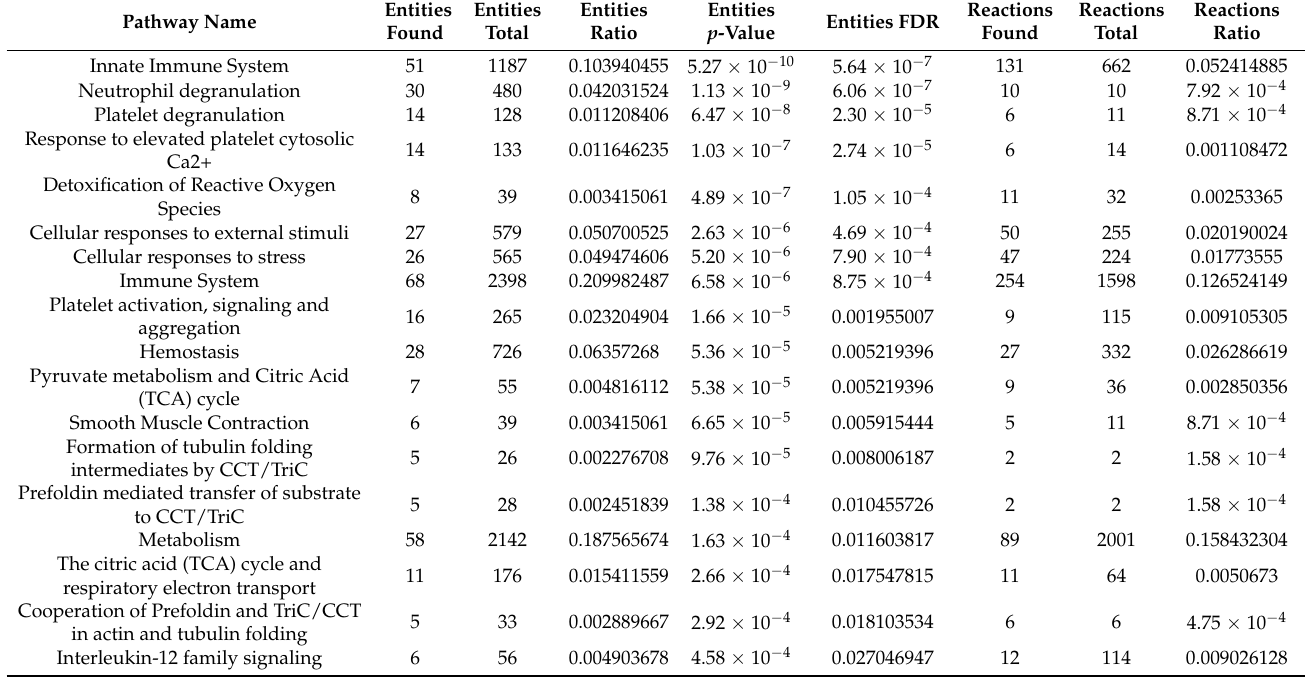
Figure 2. Pathway overrepresentation analysis of the protein elements characterizing the ND GBM tumor zone. The Reactome hierarchical pathway overrepresentation analysis in reference to Homo sapiens database found 168 identifiers over the 193 of the input list of the tumor zone and outlined the 25 most relevant pathways listed in Table 1, following a binomial test to calculate the result probability and by correcting the p -values for the multiple testing. Table 1. Result of the 25 most relevant Reactome pathways overrepresented in ND GBM tumor zone in p -value decreasing